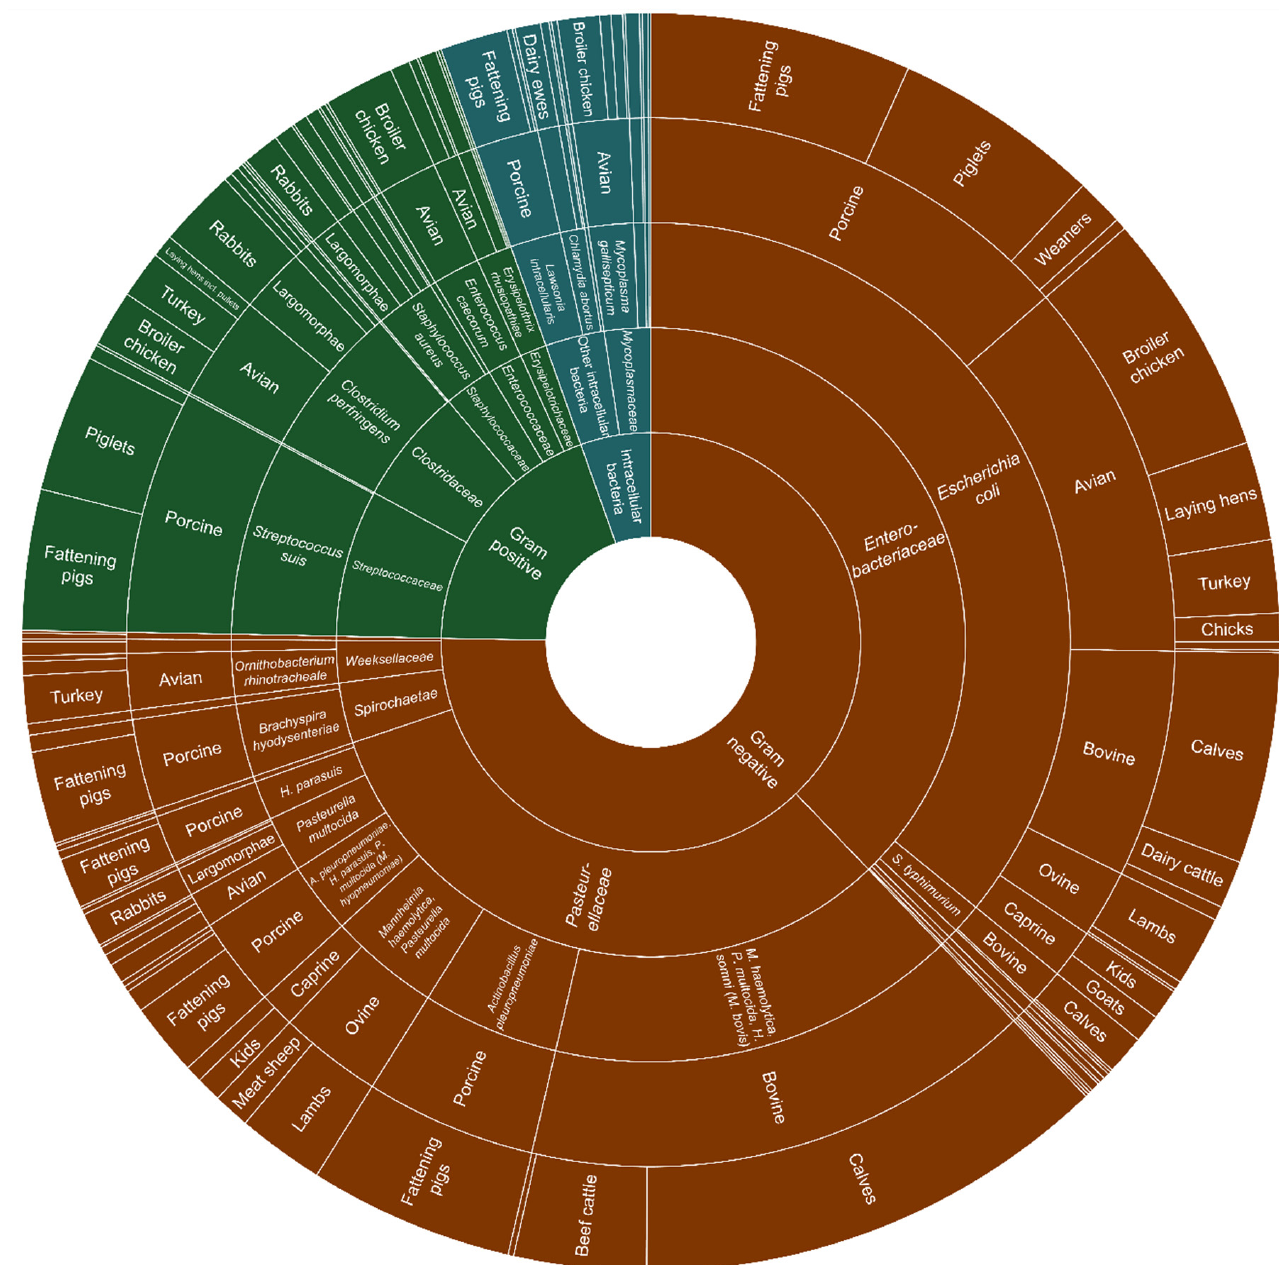
Figure 2. Sunburst chart plotted in Excel showing gram ‐ negative bacteria (brown), gram ‐ positive bacteria (green) and intracellular bacteria (blue) and the total relative abundance of bacteria classification (first two interior circles), bacteria species (third circle), affected animal species (fourth circle) and production stage (exterior circle) indicated by responding veterinarians (Q8 with n = 1385 responses, multiple answers possible) as causing the infections with the most devastating effect on animal health and welfare.